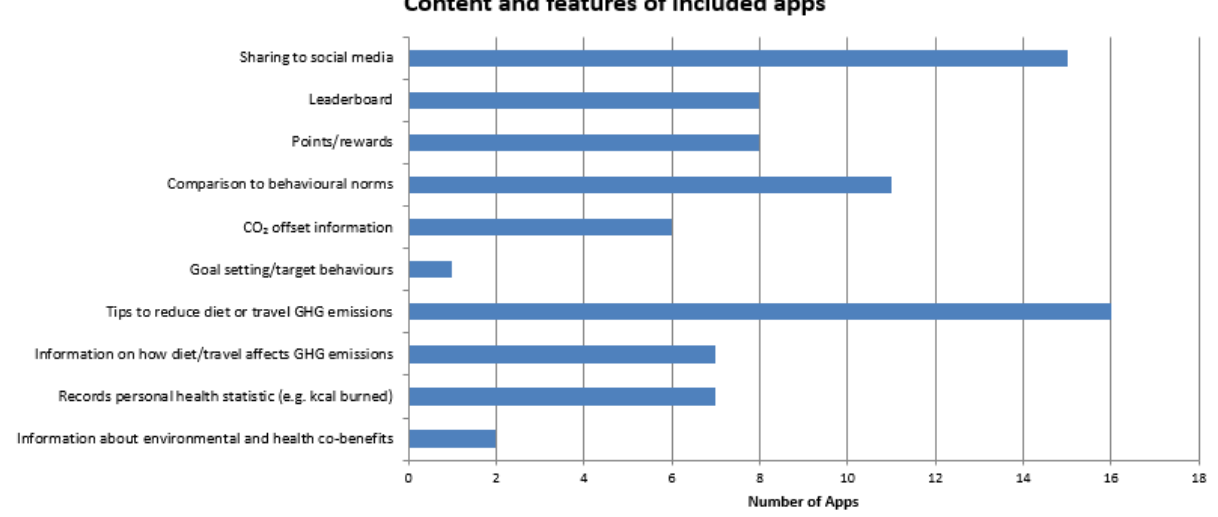
Figure 2. Typical features or information included in travel- or dietary-based